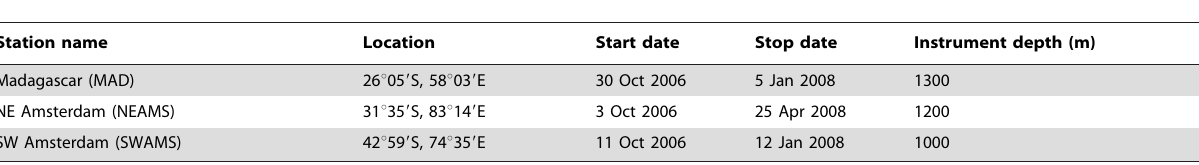
Table 1. Deployment location, dates and depth for hydrophone